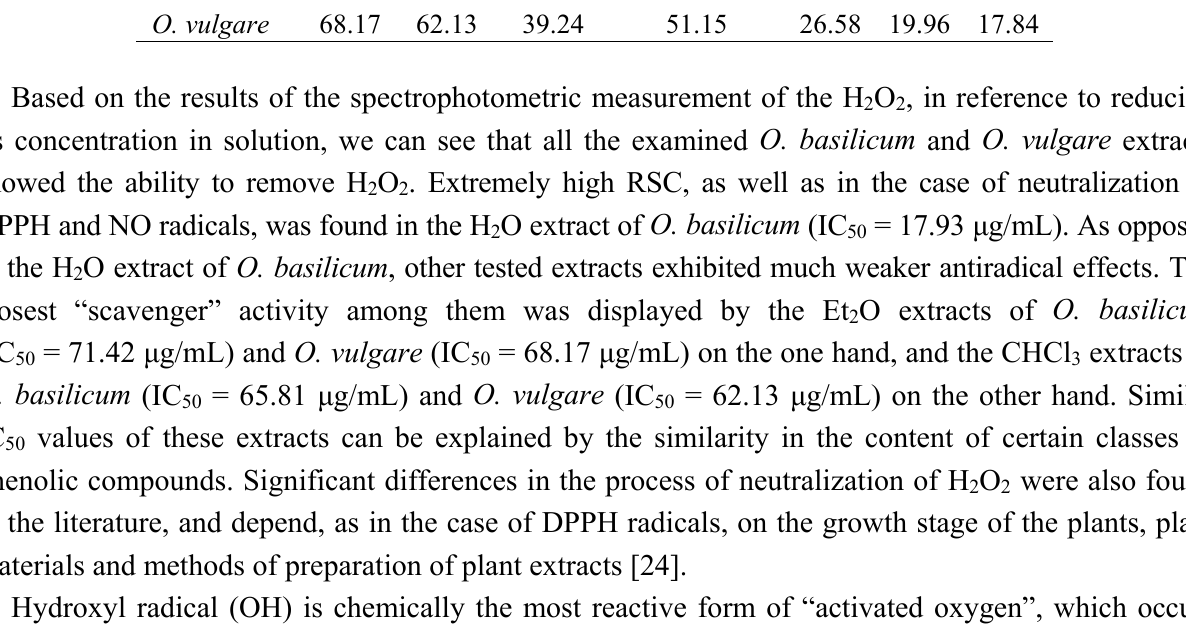
O radical with O. basilicum L. 2 2